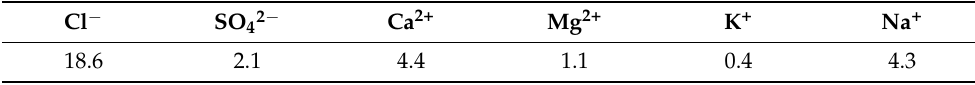
Table 2. Concentrations of ions in seawater a (g/L).